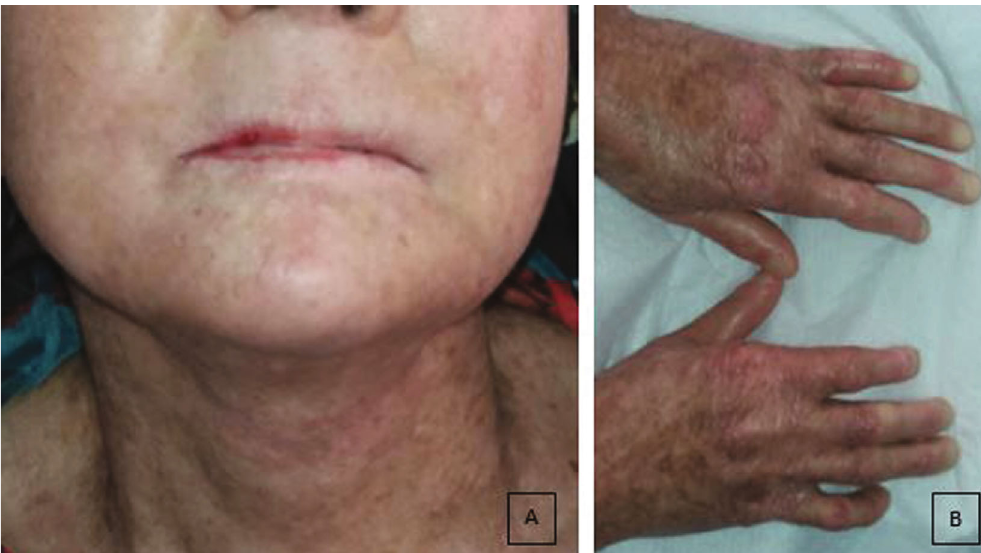
Figure 1: (a) The image showing multiple hypo- and hyperpigmented macules, prominent poikilodermatous changes, xerosis, alopecia, and atrophy of the skin. (b) The image showing cigarette paper-like wrinkling on the dorsum of the feet and hands. Atrophy and adhesions were detected in the fi ngers.